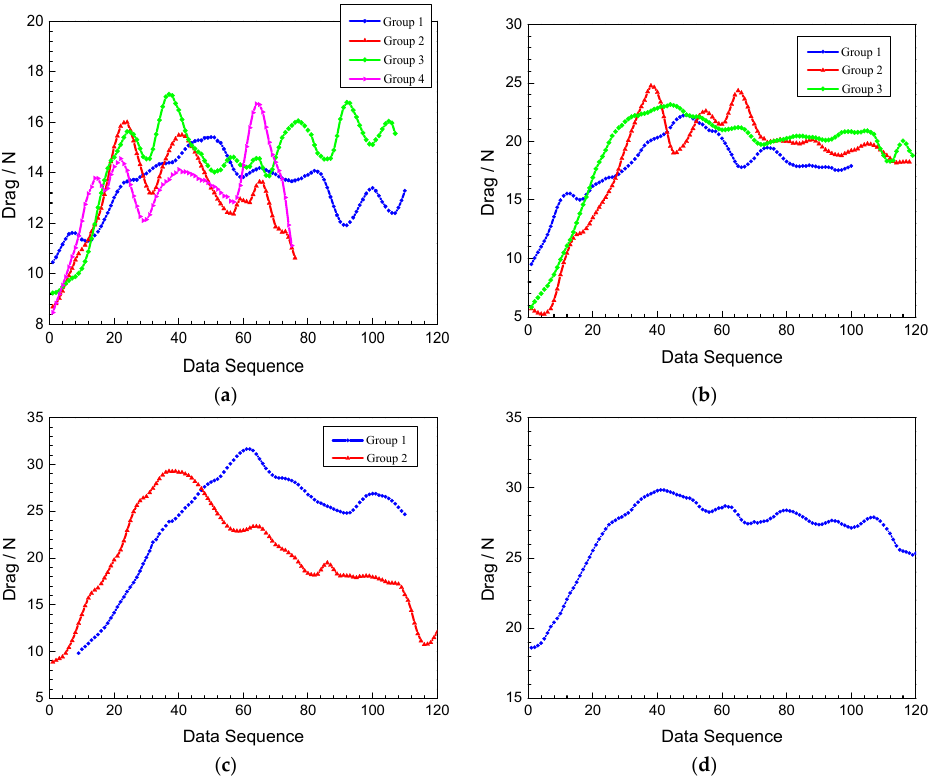
Figure 12. Local drag test results of the cement column in the rubber cylinder with sand: ( a ) Little sand; ( b ) more sand; ( c ) a large amount of sand; and ( d ) huge amounts of sand. It can be seen from Figure 12b that the drag increases to reach a peak value and then keeps it, which is mainly affected by the increasing sand accumulation in the wellbore. Figure 12c shows that the drag further increases to form a peak value and then decreases, which is mainly affected by a lot of sand particles accumulated in the wellbore. The main reason for the stable curve after the peak value in Figure 12d is that huge amounts of sand particles are piled in the wellbore. Figure 13a shows stable sections of three groups of typical drag curves of the cement column in the hard plastic cylinder. When a small amount of sand particles are in the hard plastic cylinder, local drag results in the early stage of the test process in each test group are shown in Figure 13b. If the hard plastic cylinder has lots of sand particles, then local drag results of the cement column are shown in Figure 13c.